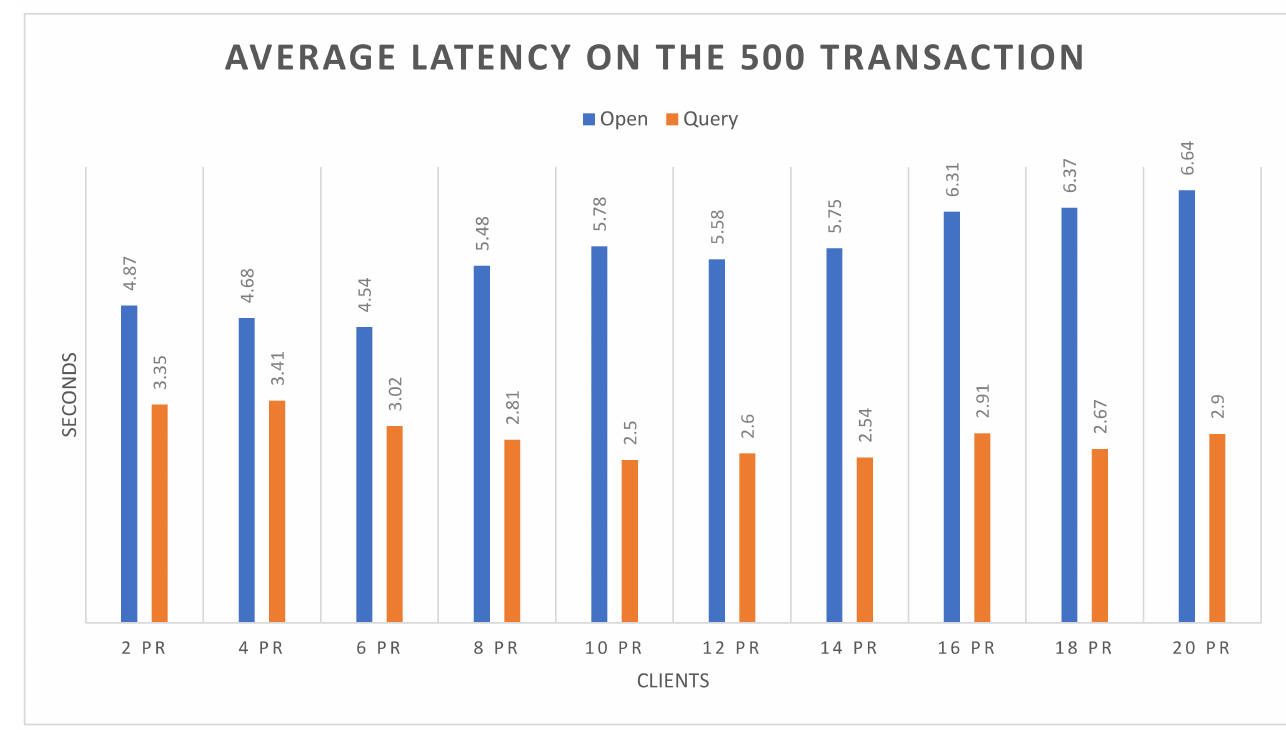
Figure 8. Average latency on 500 transactions.